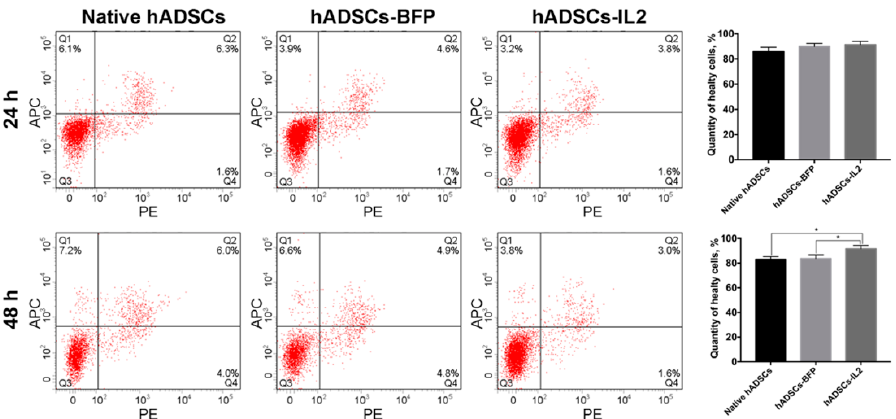
Figure 2. Viability analysis of native and genetically modified hADSCs. Cells were cultured for 24 and 48 h and stained with Annexin/PI to detect apoptosis and necrosis. Data were obtained using flow cytometry. Q1: number of apoptotic cells. Q2: number of late-apoptotic cells. Q3: number of healthy cells. Q4: number of necrotic cells. Each box represents the mean ± SD ( n = 6) of two biological replicates of the number of healthy native hADSCs, hADSCs-BFP or hADSCs-IL2. * p < 0.05. Like native hADSCs, the genetically modified hADSCs-IL2 were able to differentiate into adipogenic, osteogenic and chondrogenic lineages (Figure 3). Together, these data indicate that hADSCs-IL2 express IL2 mRNA and protein which did not affect the prolif- erative properties and viability, and the differentiation properties of this cell population.